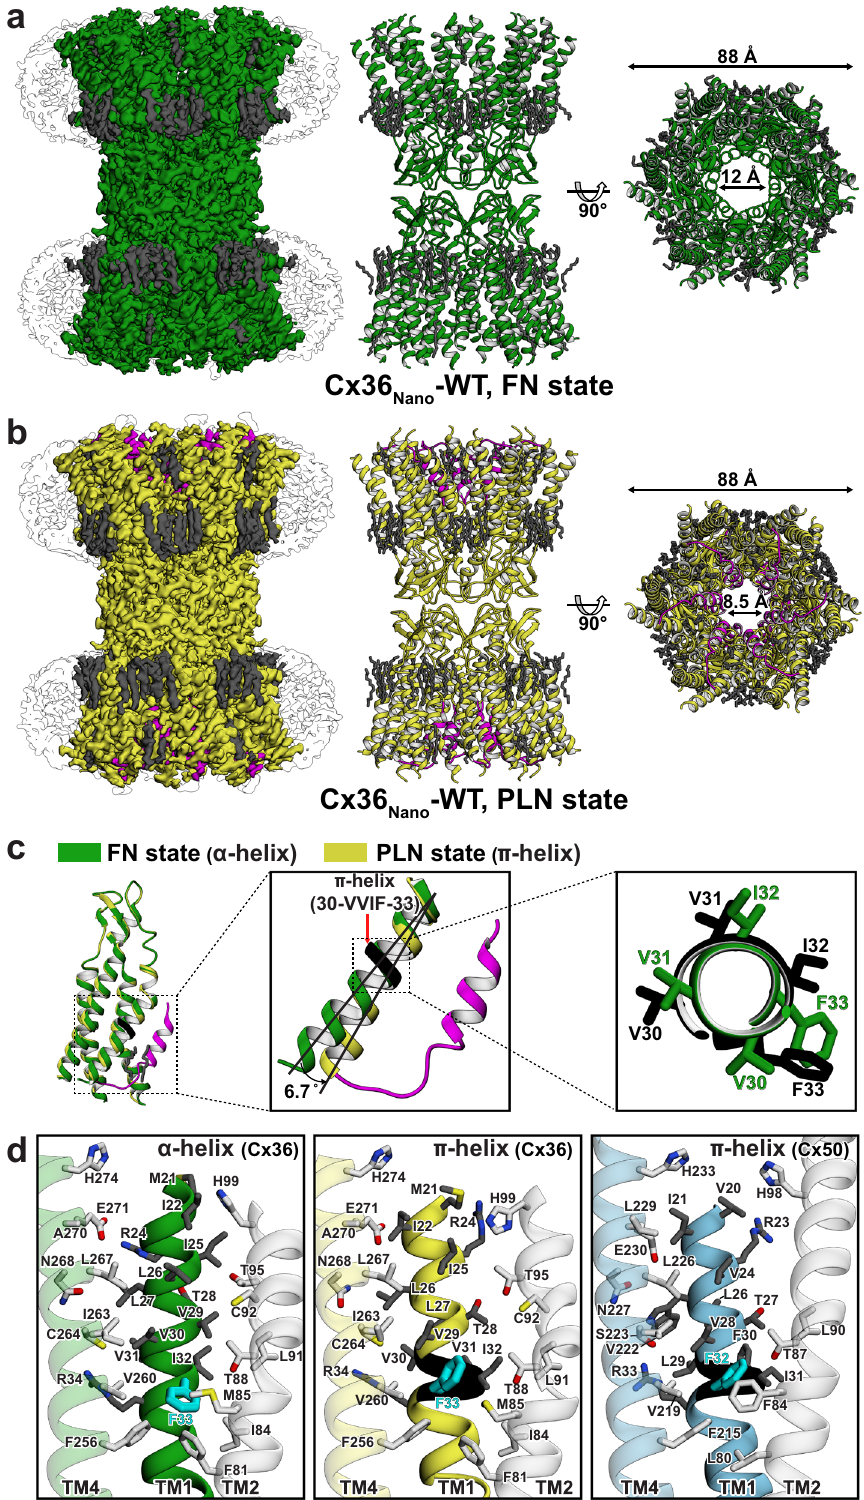
Fig. 2 | Structural comparison of Cx36 FN and PLN states in lipid nanodiscs. a , b Cryo-EMreconstructionmapandribbonrepresentationofCx36 Nano -WTinthe FNand PLN states, respectively. The acyl chains, nanodiscs, and NTHs, are colored indeemgray,white,andmagenta,respectively. c Structurealignmentofprotomers oftheFNandPLNstates,coloredingreenandyellow,respectively(left).TM1ofthe PLN state is bent towards the channel pore at ~6.7°, and NTH binds to the